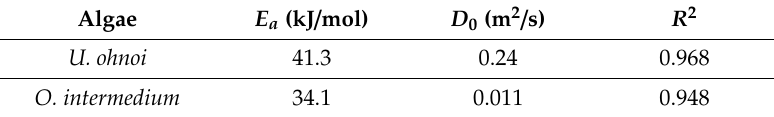
Table 5. Activation energy and di ff usion pre-exponent for radiative drying.